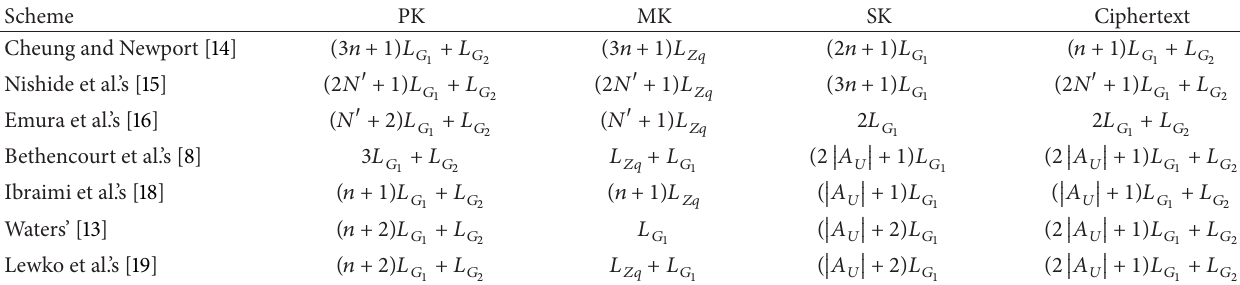
Table 2: Comparison of size of keys and ciphertext in different CP-ABE schemes.